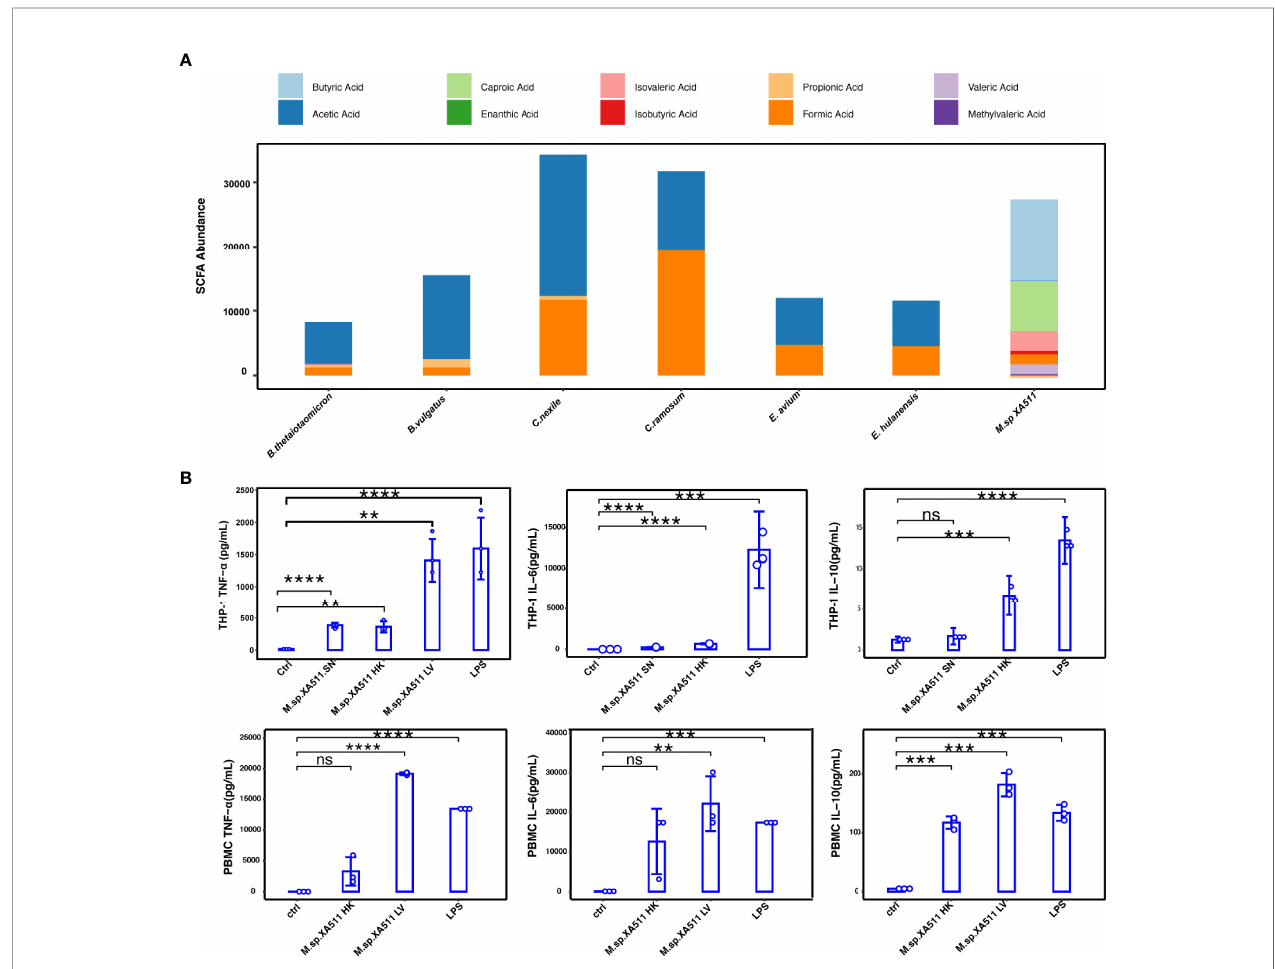
FIGURE 4 | SCFA production of Megasphaera sp. XA511 and effects of Megasphaera sp. XA511 on producing proin fl ammatory cytokines. (A) The production of different SCFAs by Megasphaera sp. XA511 ( M.sp.XA511 ) and other bacteria ( B.thetaiotaomicron , B.vulgatus , C.ramosum , C.nexile , E.hulanensis and E.avium ) were measured by GC-MS. The bacteria were grown until the Late log phase before the measurement of fatty acids in supernatants. (B) The secretion of cytokines from THP-1 and PBMCs treated with supernatant derived from Megasphaera sp. XA511 ( M.sp.XA511 -SN) or the heat killing ( M.sp.XA511 -HK) or live ( M.sp.XA511- LV) fraction was determined. The one-way ANOVA analysis was used to determine whether there are any statistically signi fi cant differences between the different bacteria and control group. NS indicates not signi fi cant (p > 0.05), whereas the asterisk indicates signi fi cant difference (**P < 0.01; ***P < 0.001; ****P <